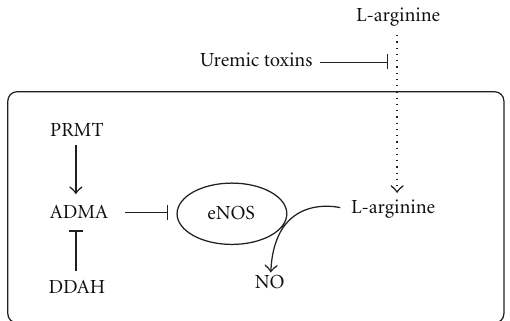
Figure 2: Potential mechanisms of L-arginine deficiency in chronic kidney disease (CKD). Asymmetric dimethylarginine (ADMA) is a competitive inhibitor of eNOS and ADMA levels are increased in CKD. Synthesis of ADMA occurs via protein arginine methyl- transferase (PRMT) which may exhibit increased expression and activity in CKD. Expression of the enzyme dimethylarginine dimethylaminohydrolase (DDAH) may be decreased in CKD resulting in reduced degradation of ADMA. L-arginine transport into endothelial cells can be inhibited by increased levels of uremic toxins as disease progresses and result in reduced substrate availability for NO